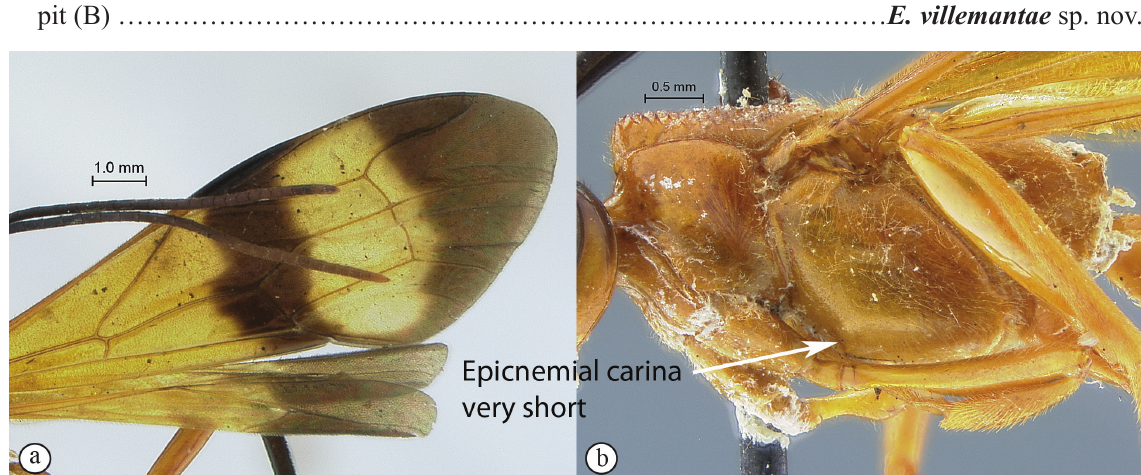
64. Wings blackish with subapical lighter patch (A); epicnemial carina reaching level of mesopleural